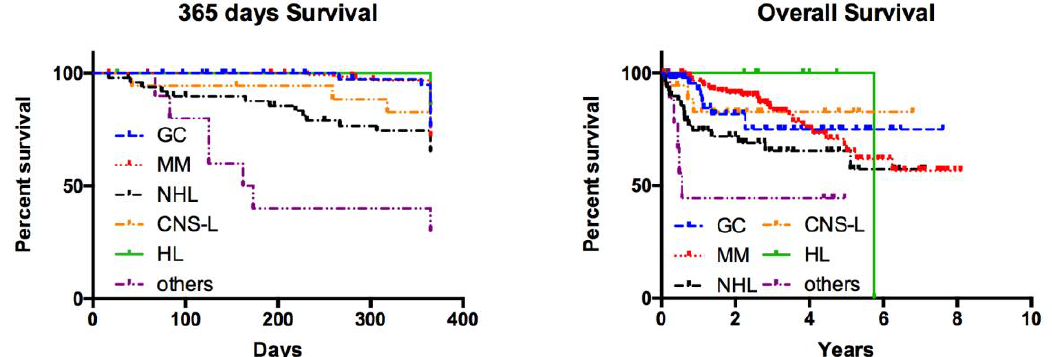
Figure 1. The 365-day survival and overall survival of patients treated with high dose chemotherapy and subsequent ASCT. Median survival over the period of follow-up was reached in the sarcoma and rare tumour group (median overall survival was 167 days).